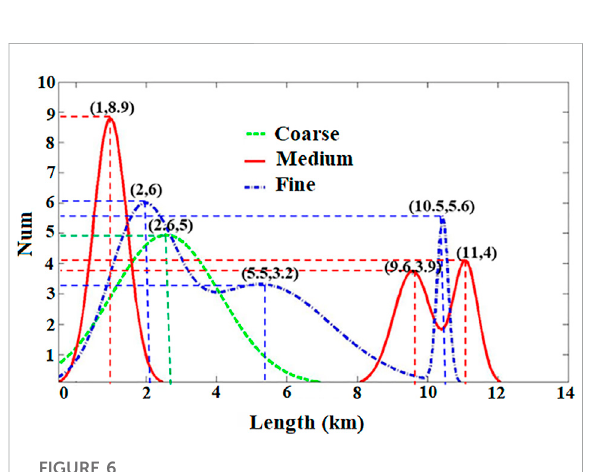
FIGURE 6 Shale layer extension length distribution for different sediment grain